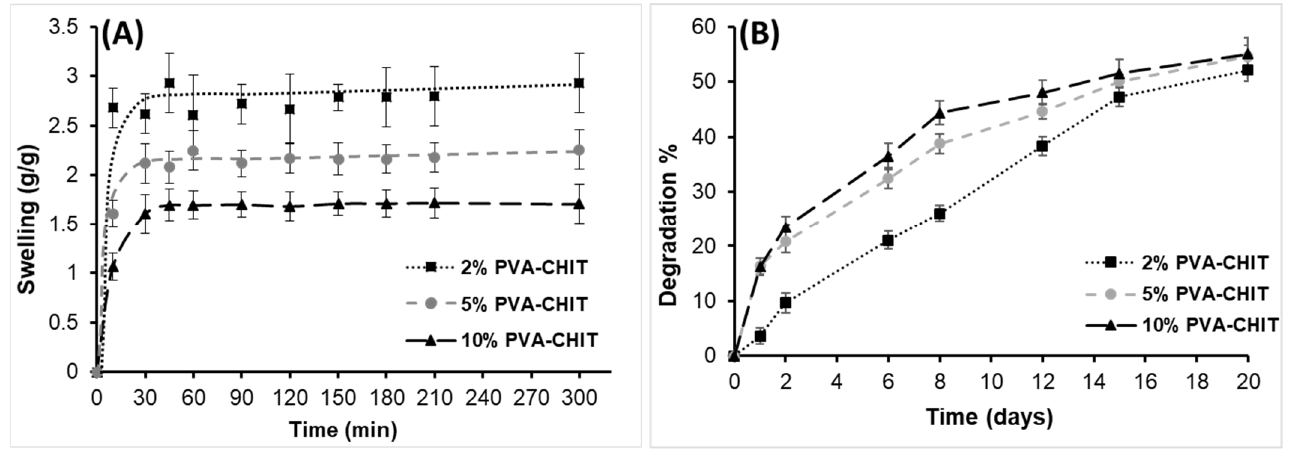
Figure 5. The swelling (g/g) ratio of the PVA-CHO/CHIT-SH hydrogels at different (2, 5, and 10 w / v %) concentrations in PBS buffer solution at 37 °C ( A ). Degradation of hydrogels at different (2, 5, and 10 w / v %) concentrations in 0.15% lysozyme/PBS buffer solution at 37 °C ( B ).